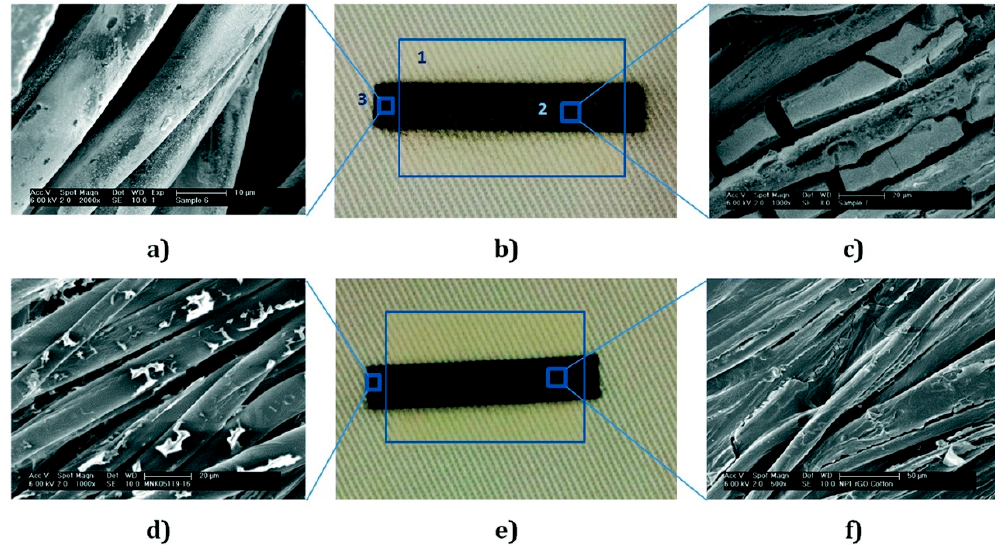
Figure 10. The different conductive paths, which were IJP on the untreated and treated areas of the cotton fabric with NP1. ( a ) and ( c ) show the SEM images of the untreated cotton fabric coated with 6 layers of IJP silver ink (×2000), and the IJP silver conductive path (6 layers) onto treated cotton fabric with 12 layers of NP1 (×1000), respectively. ( b ) and ( e ) show 3 different areas of the cotton fabric for silver and rGO ink, respectively: (1) area printed with 12 layers of NP1; (2) 6 layers of IJP silver (or rGO) conductive path onto NP1; and (3) untreated cotton fabric coated with 6 layers of IJP silver (or rGO) ink. ( d ) and ( f ) show the SEM images of the untreated cotton fabric coated with 6 layers of IJP rGO ink (×1000), and the IJP rGO conductive path (6 layers) onto treated cotton fabric with 12 layers of NP1 (×500), respectively. Reproduced from [193], with permission from the Royal Society of Chemistry, 2017.